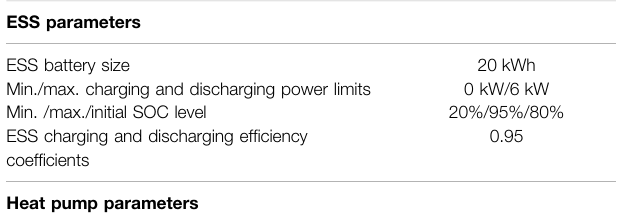
TABLE 1 | Key parameters of ESSs and heat